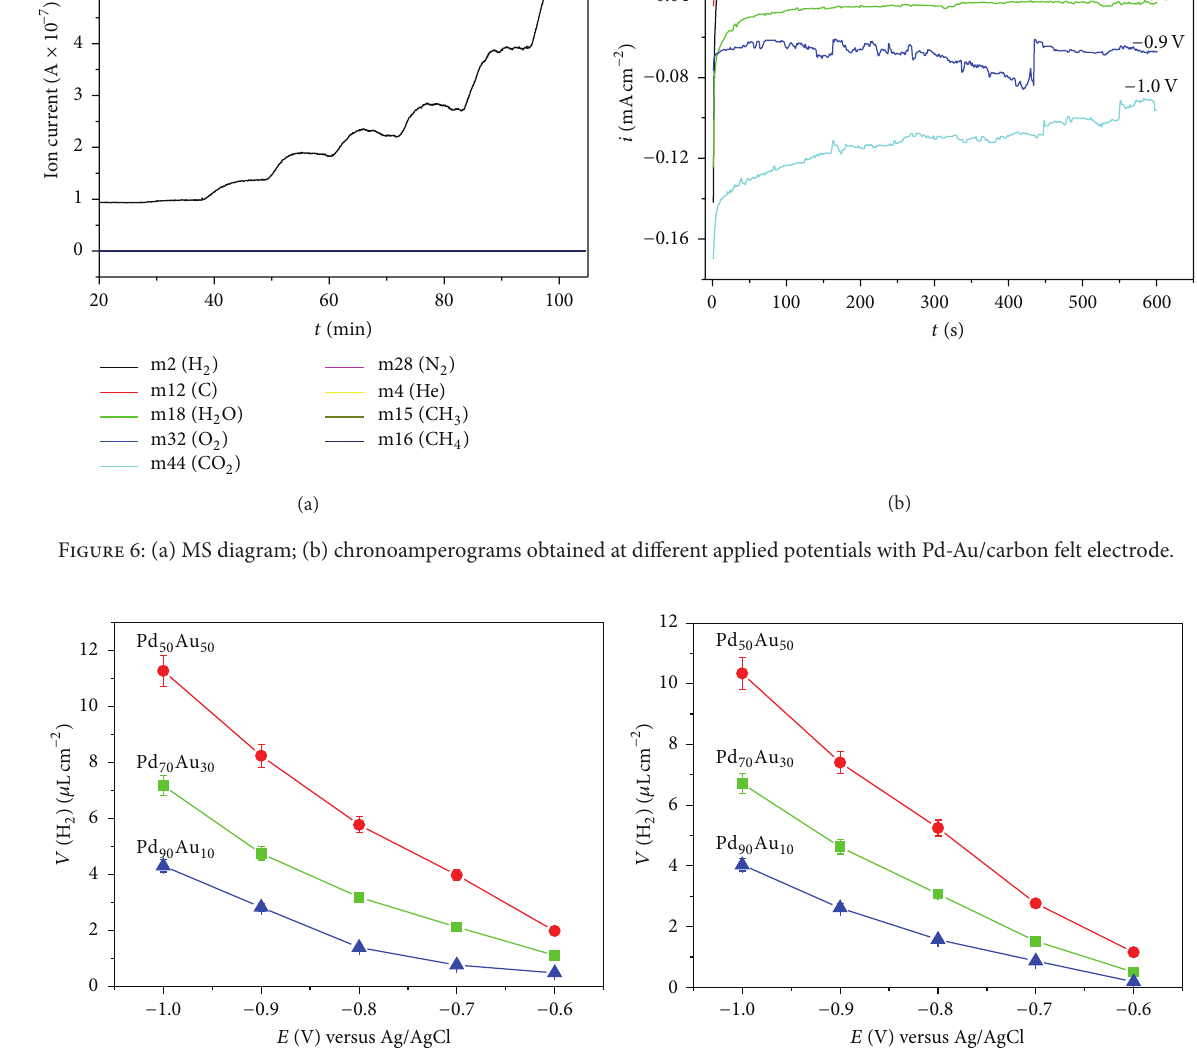
phosphate buffer. The minimum voltage needed to